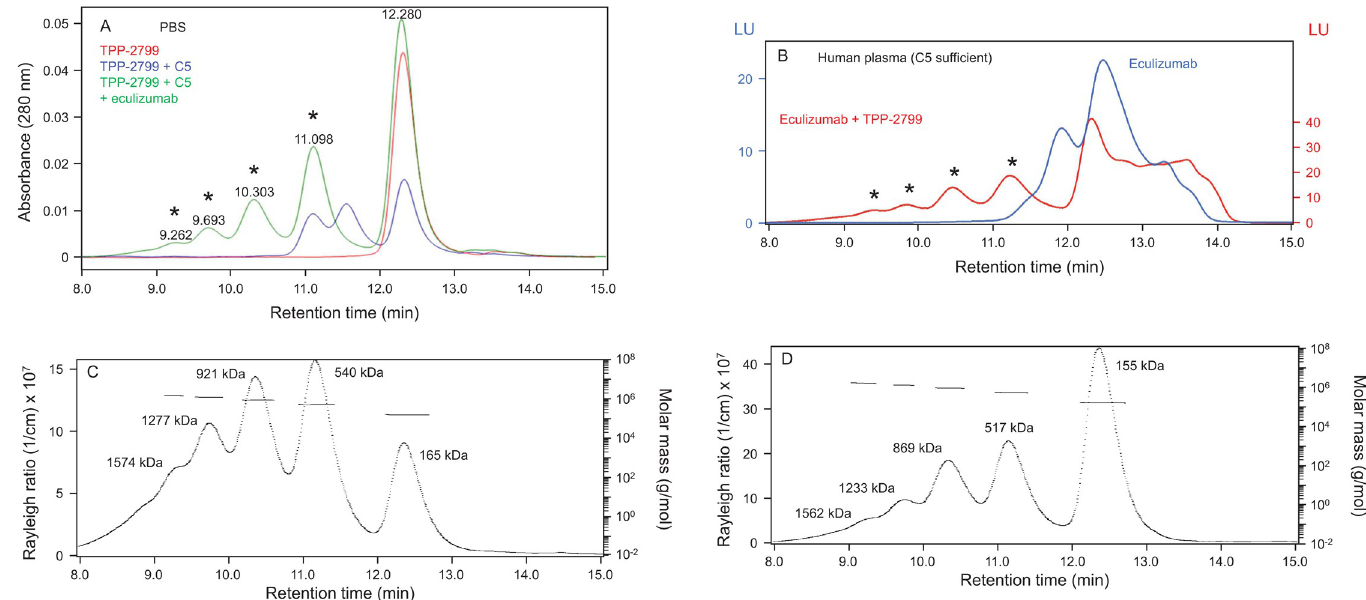
Fig 3. TPP-2799 induces the formation of very large complexes in the presence of eculizumab and C5. (A) TPP-2799 (700 nM) alone, in the presence of C5 (400 nM), or in the presence of C5 (400 nM) and eculizumab (700 nM) in PBS. Large, early-eluting peaks observed in the presence of TPP-2799, C5 and eculizumab are denoted with asterisks. (B) Reconstitution of Alexa Fluor 488-eculizumab (700 nM) in 80% human plasma in the absence or presence of TPP-2799 (700 nM). Early, eluting peaks observed in the presence of both the labeled eculizumab and TPP-2799 are denoted with asterisks. Data were plotted to normalize total chromatogram fluorescence area under the curve between the two treatment groups. (C) Rayleigh ratios and molar masses of complexes formed among TPP-2799 (700 nM), C5 (400 nM), and eculizumab (700 nM) in PBS. (D) Rayleigh ratios and molar masses of complexes formed among TPP-2799 (3500 nM), C5 (400 nM), and eculizumab (700 nM) in PBS. Abbreviations: C5 = complement component 5; LU = luminescence units; PBS = phosphate-buffered saline.